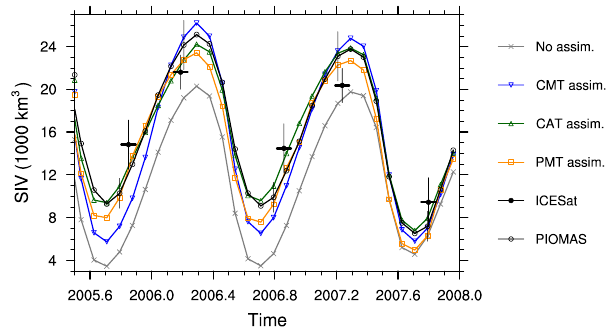
Fig. 5. Monthly mean of Arctic sea-ice volume between 2005 and 2008, as modelled with MPIOM-ECHAM5 and estimated from ICESat observations and the PIOMAS reanalysis. Thin vertical lines give uncertainties in ICESat and PIOMAS estimates as given by Kwok et al. (2009) and Schweiger et al. (2011).